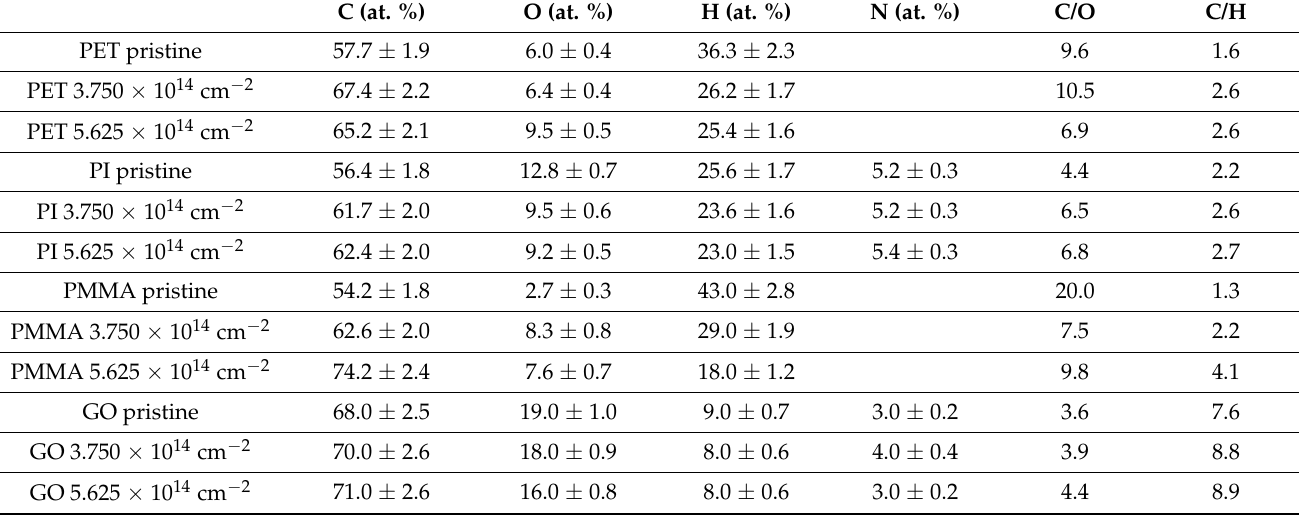
Table 1. The GO, PET, PI, and PMMA elemental composition before and after irradiation with carbon ions determined using RBS and ERDA. C (at.